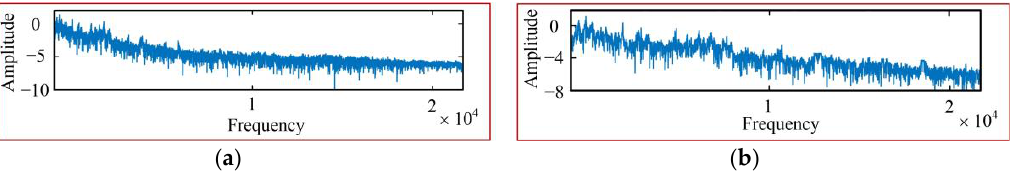
Figure 10. ( a ) Spectrogram of the original signal; ( b ) Spectrogram of the denoised signal.